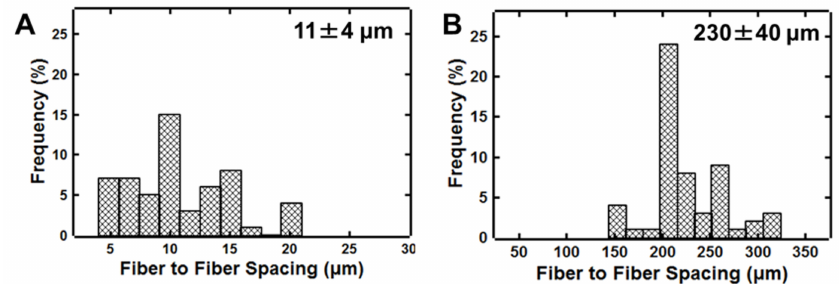
Figure 5. Fiber to fiber spacing distributions achieved by ( A ) electrospinning with a mandrel and ( B ) shear force fiber spinning using 30 wt.% polystyrene in 7:3 v : v toluene:acetone. The relative standard deviation of fiber using shear force fiber spacing is 2-fold lower than electrospinning with a mandrel.